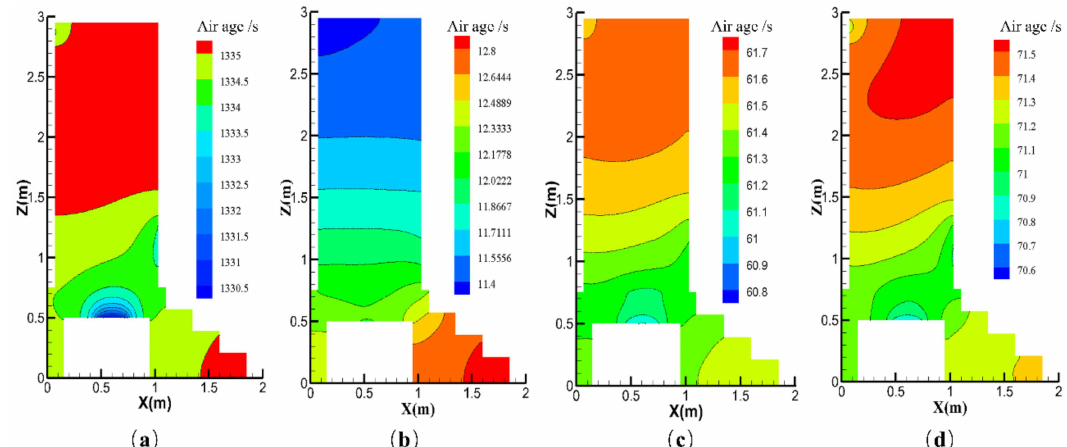
Figure 8. Contours of air age under different ACH (unit: h − 1 ) values for Cases 1 and 2. Case 1: ( a ) ACH = 5, ( b ) ACH = 10; Case 2: ( c ) ACH = 5, ( d ) ACH =